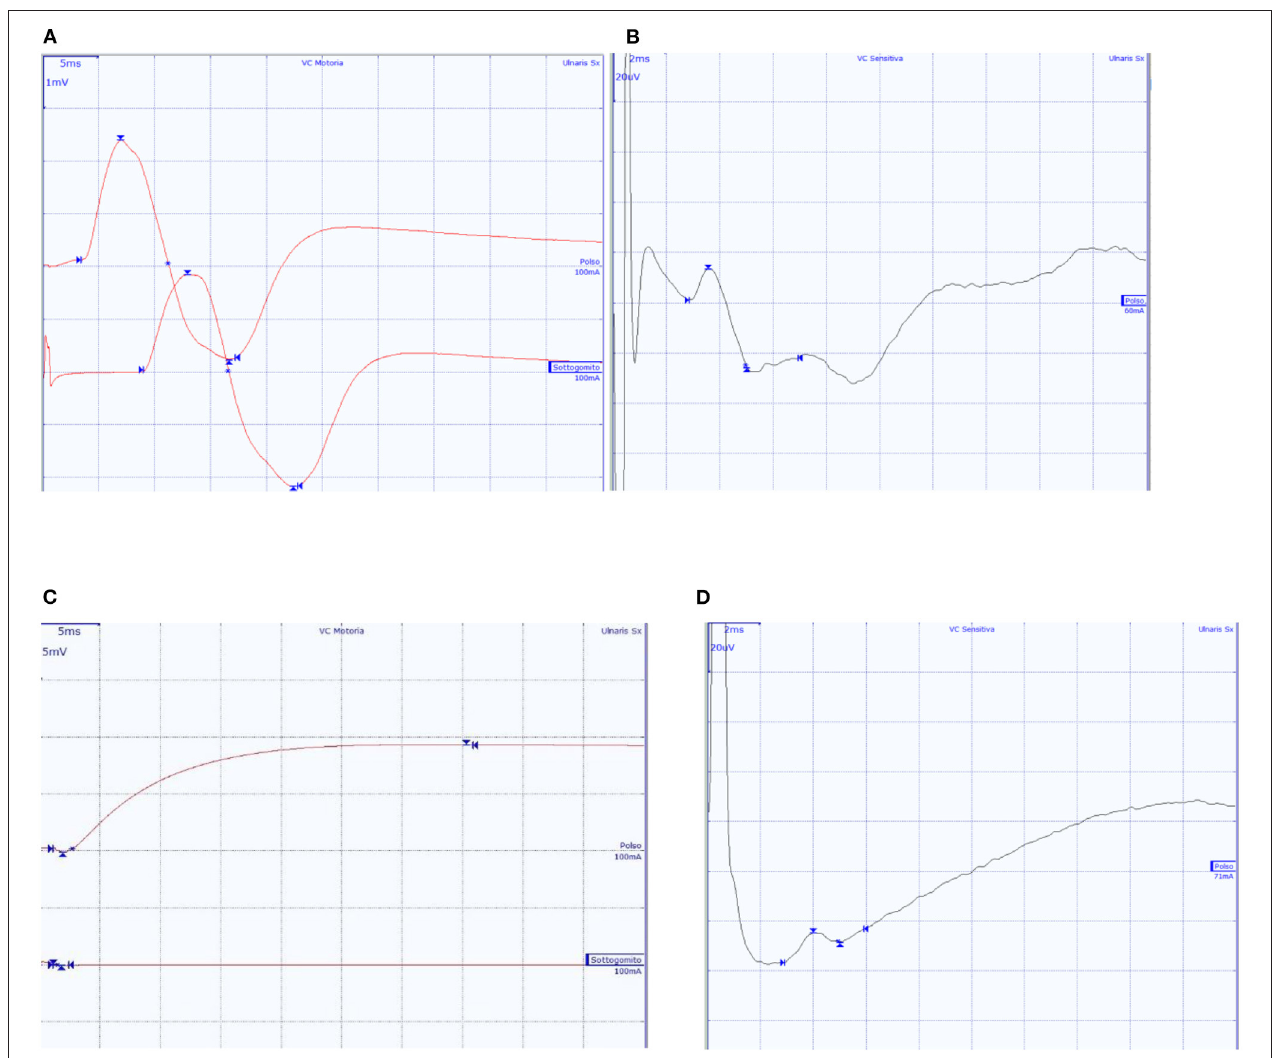
FIGURE 2 | Ulnar nerve CMAP and SAP of two subjects. (A,B) A 65-year-old male patient with normal findings; (C,D) A 57-year-old patient with diffuse axonal neuropathy, with absent ulnar nerve CMAP, and SAP within normal